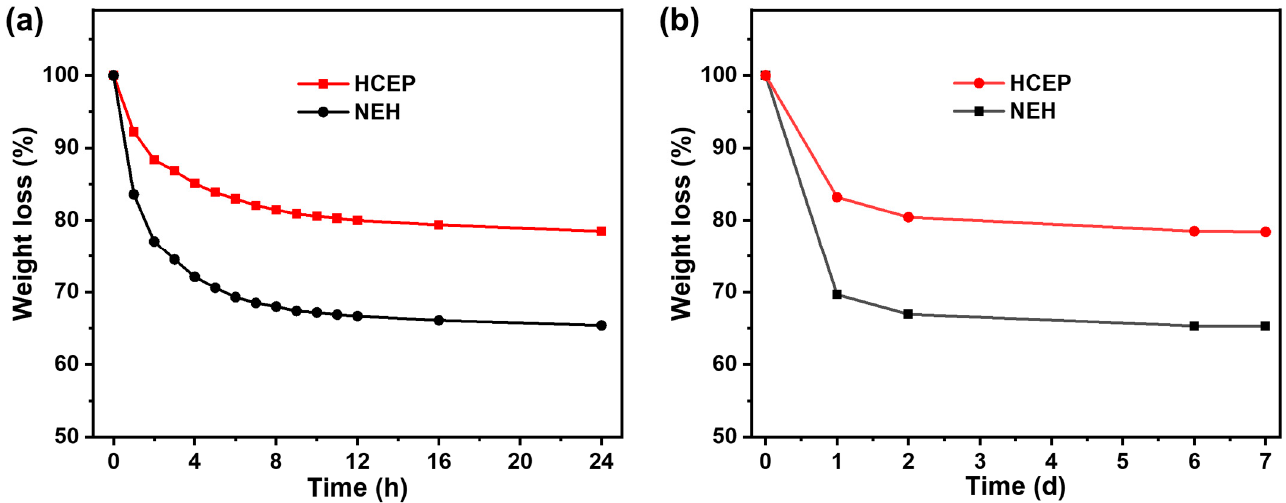
Figure 4. The weight loss curves of NEH and HCEP. ( a ) For 24 h, at 40 °C, 10% humidity, and ( b ) for 7 d at 20 °C, 20% humidity.